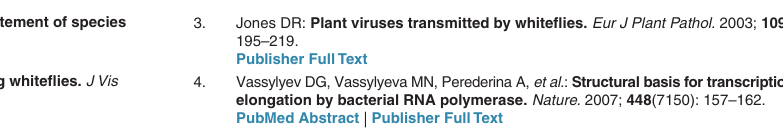
Supplementary Table 1. Distribution of the endosymbionts and number of contigs matching core genes present within each endosymbiont bacteria present in four SSA1 B. tabaci samples from this study. Click here to access the